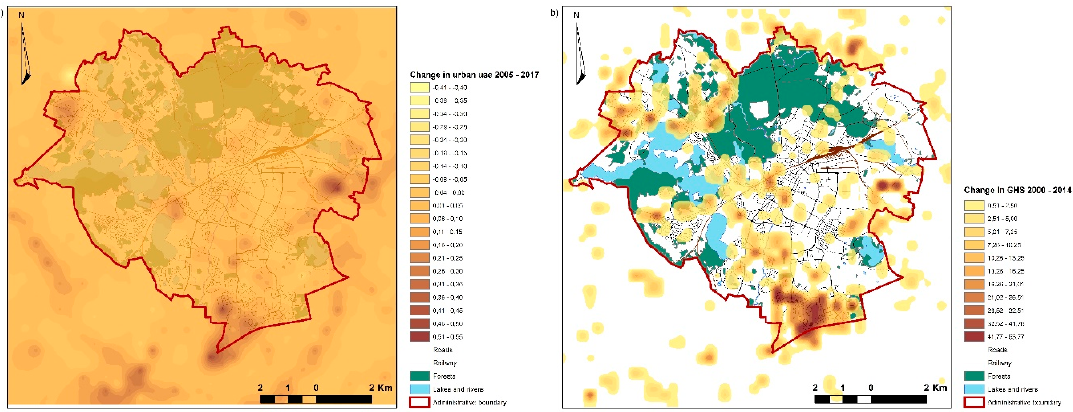
Figure 7. Urban development and GHSL data: ( a ): fuzzy set theory 2005–2017; ( b ): GHSL 2000–2014